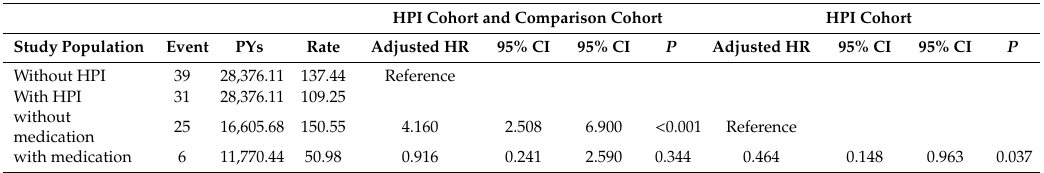
Table 4. Factors of irritable bowel syndrome (IBS) among study population and PHI cohort by using Cox